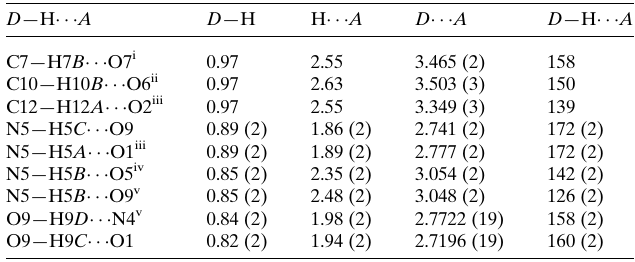
Table 1 Hydrogen-bond geometry (A˚ , (cid:4) ).